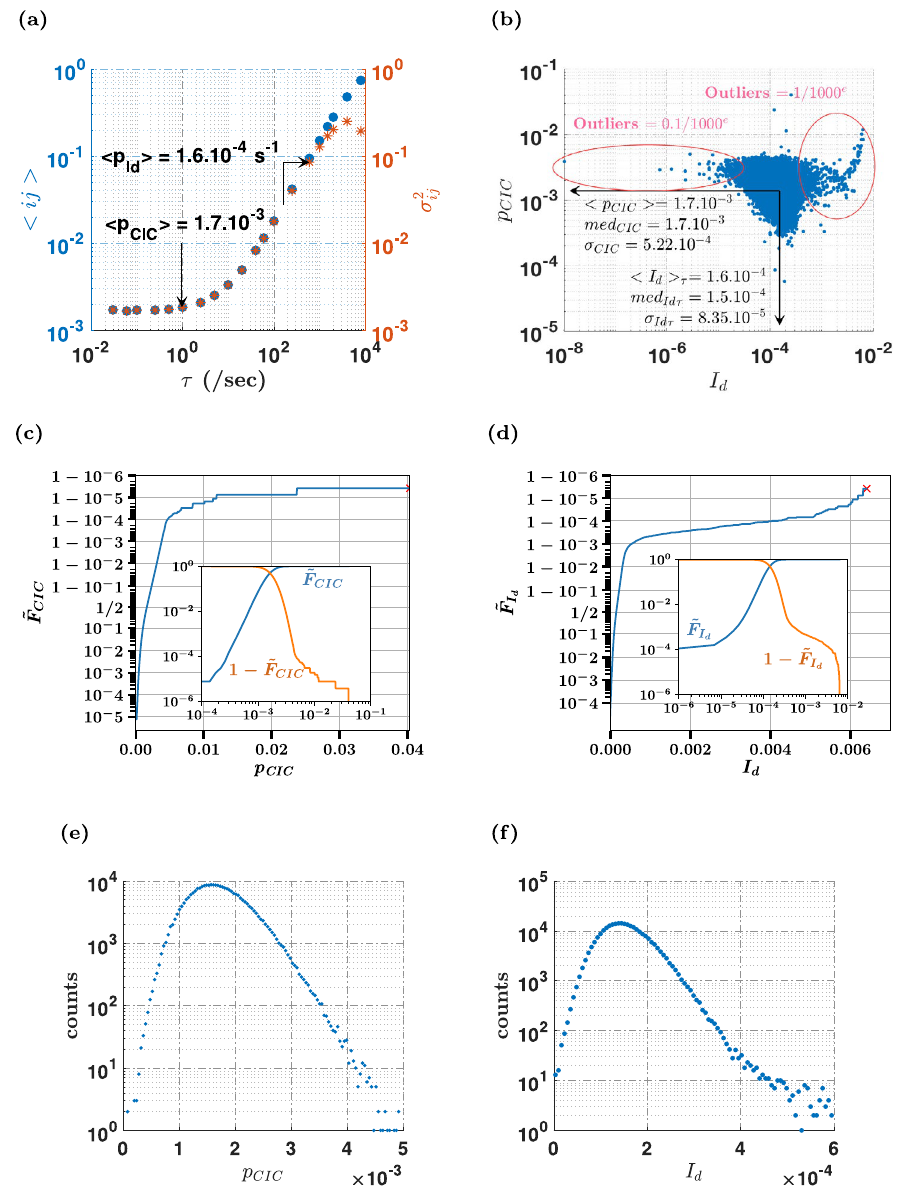
Figure 1. Statistics of pixel dark responses. For all pixels, the response in the binary photon counting mode was assessed from the average of the response obtained over long time series in the "complete darkness" with a cooling temperature – 85 °C, and for a range of exposure times τ (see “Materials and methods” section). The contribution of cosmic rays has been removed. ( a ) Average over all pixels of the response < p X > ij , and > ij . ( b ) For each pixel, the linear fit of the dark response gives the probability p CIC of a the variance < σ 2 p X CIC count, and of the probability p I of a dark current count per second. The biparametric plot represents the d distribution of these parameters for each pixel, together with the statistical analysis of the two distributions. Outlier pixels, with dark current much smaller and much larger than the average represent 0.1% of the pixel F CIC , population each. ( c ) and ( d ) show the cumulative ( ˜ F CIC , ˜ F I ) and complementary cumulative ( 1 d − ˜ 1 F I ) distribution functions of p CIC and p I over the detector. For inserts to ( c ) and ( d ), the vertical axes d d − ˜ represent the logarithmic scale. For the main plots ( c ) and ( d ) instead, the vertical axes are made with a special 1 / 2 ) mapping, that better shows the dispersion of outliers. This analytic mapping combines a x arc tanh ( x − ← linear representation near 1/2 with a logarithmic representation of large positive or negative deviations. ( e ) and ( f ) show the 1D histograms of p CIC and p I d